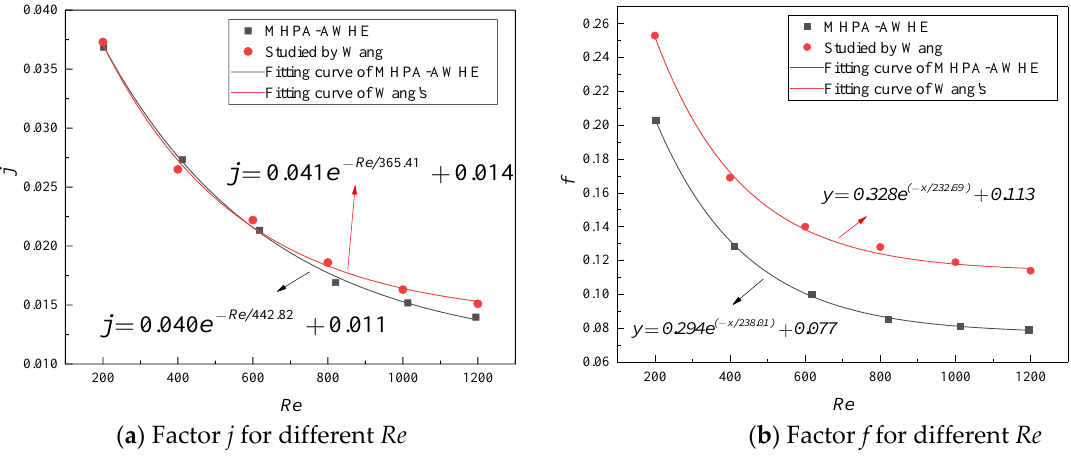
Figure 21. Distribution of ( a ) heat transfer factor j and ( b ) friction factor f for different Re. According to the experimental data and Wang’s data, the heat transfer factor j and the friction factor f were fit in the Re range from 200 to 1200, in order to modify the accurate j and f values in actual projects.